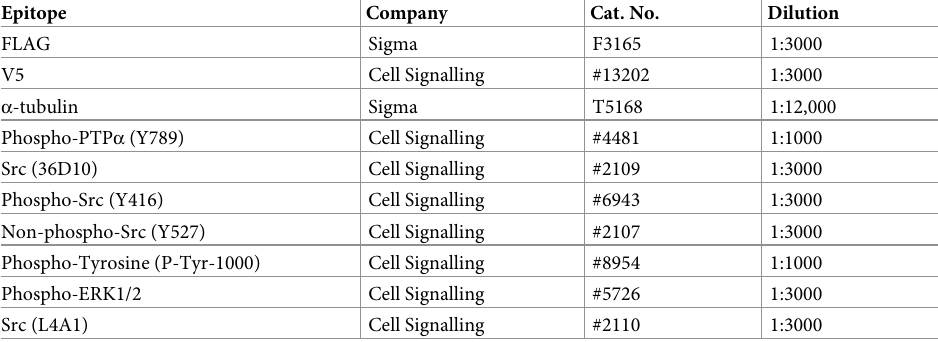
Table 1. Antibodies used in this